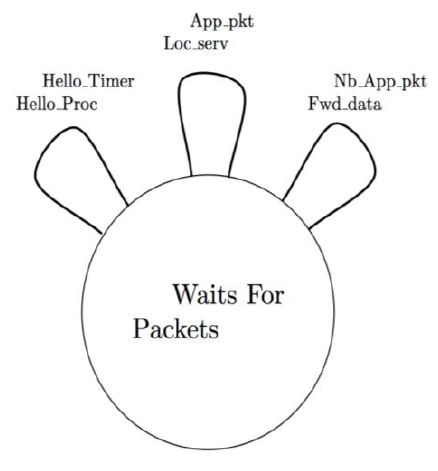
Figure 6. State machine of the interaction between the different modules of FPBR